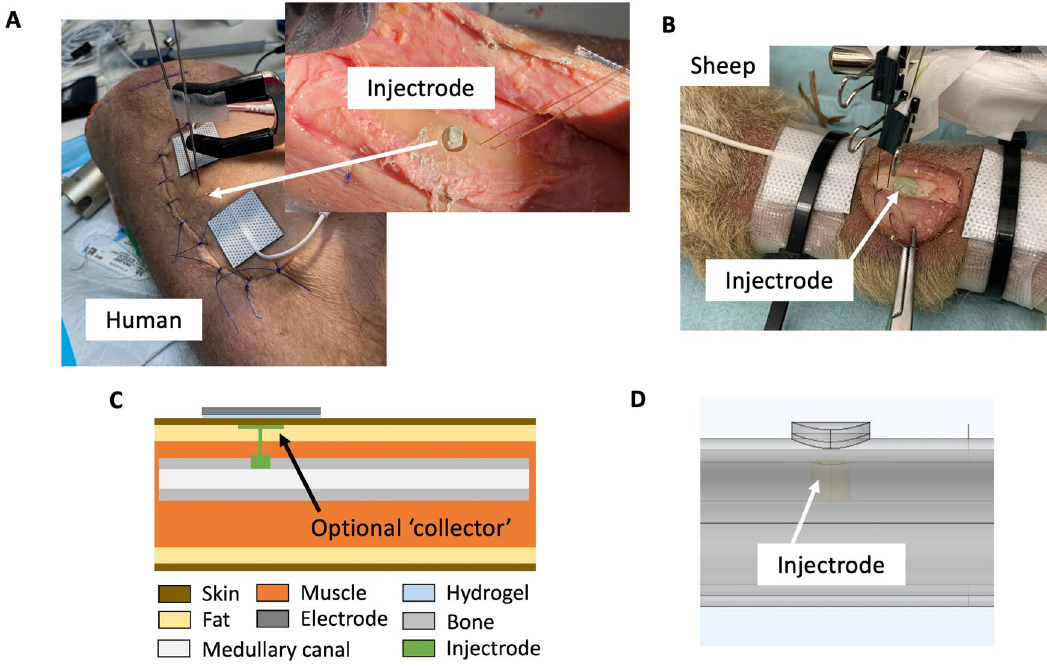
Figure 4. Injectrode to augment electric field reaching the fracture site during noninvasive EBGS therapy. ( a ) Addition of Injectrode to fracture defect under surgical flap in human cadaver. ( b ) Addition of Injectrode to fracture defect in sheep cadaver. ( c ) Illustration of Injectrode ‘collector’ placed subcutaneously with injected Injectrode wire leading to more Injectrode at the fracture site (monopolar configuration). Thereby, routing current from the surface of the body to the deep bone and increasing electric field strength reaching the fracture site. Note that the Injectrode ‘collector’ is optional for superficial fractures but will be beneficial for deep fractures. ( d ) Injectrode in the FEM model. 3D representation of schematic in ( c ) without optional Injectrode